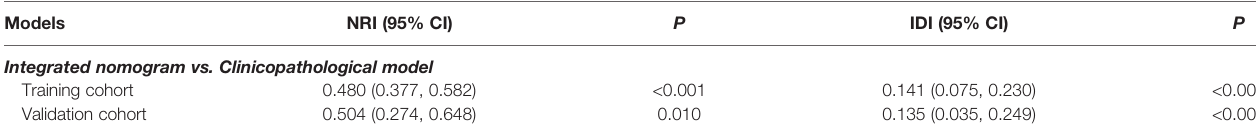
TABLE 5 | Net reclassi fi cation and integrated discrimination improvement by comparing the integrated nomogram with the clinicopathological model.